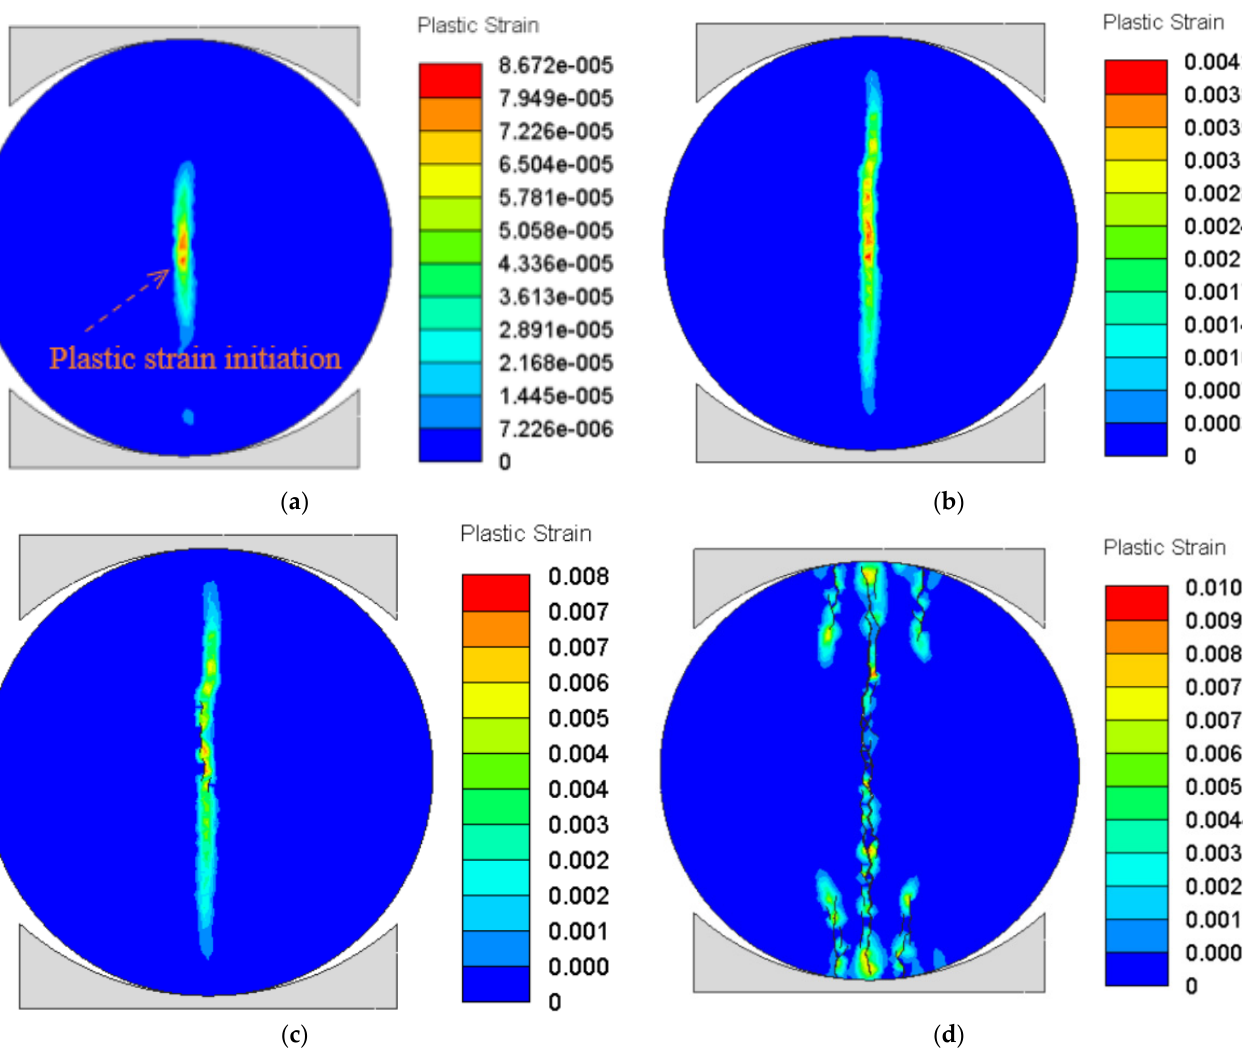
Figure 17. The plastic strain evolution with load for the Type III testing: ( a ) 23.6 kN, ( b ) 23.9 kN, ( c ) 22.6 kN (post − peak), ( d ) 11.4 kN (post − peak).